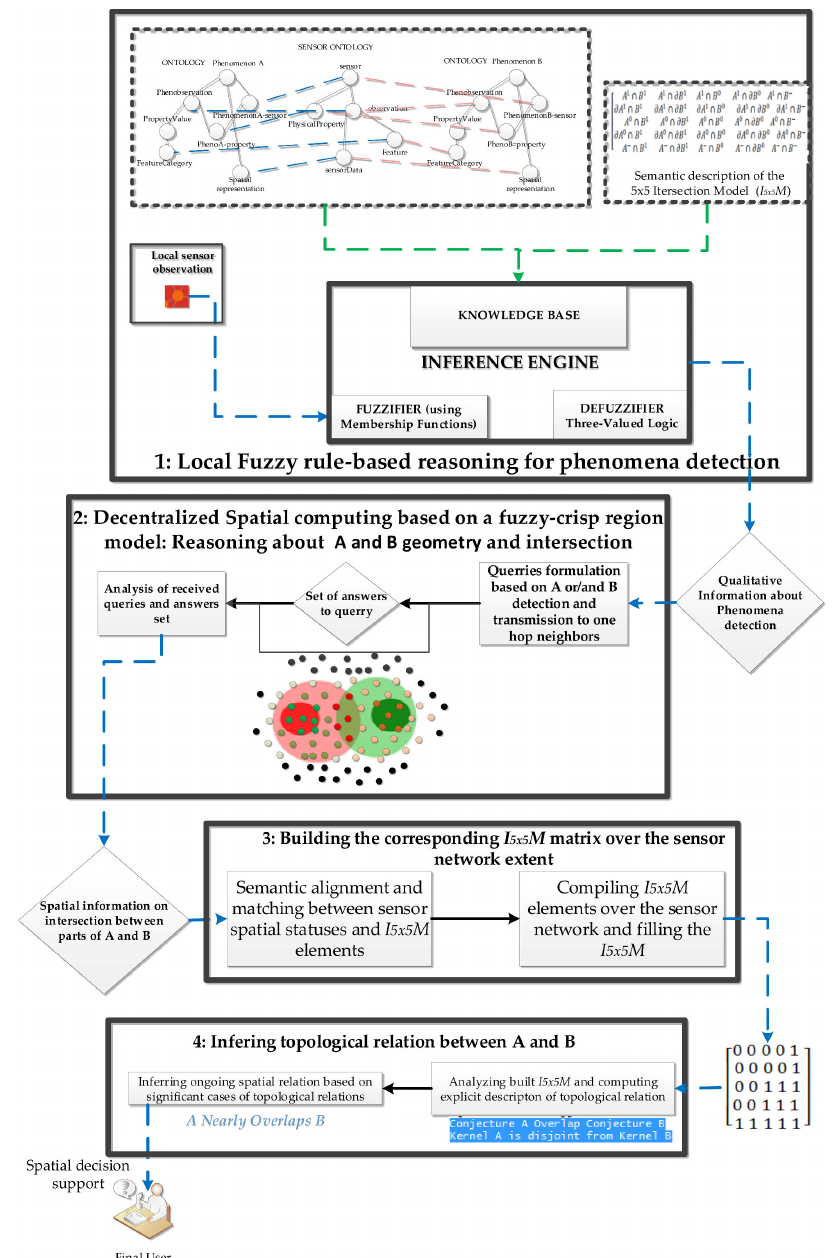
Figure 5. Conceptual framework for computing fuzzy spatial relations using I 5 × 5 M in